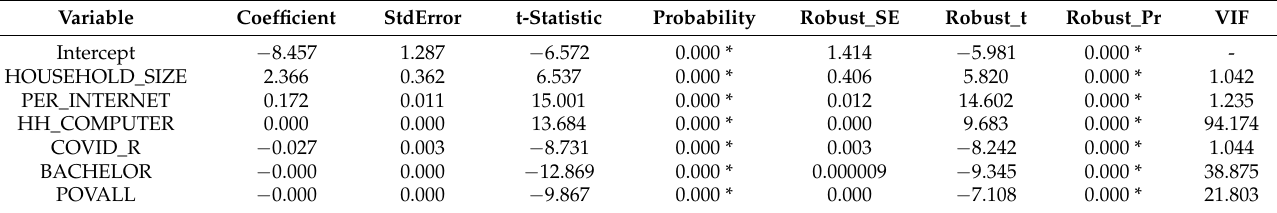
Table 4. Summary of the OLS results with six explanatory